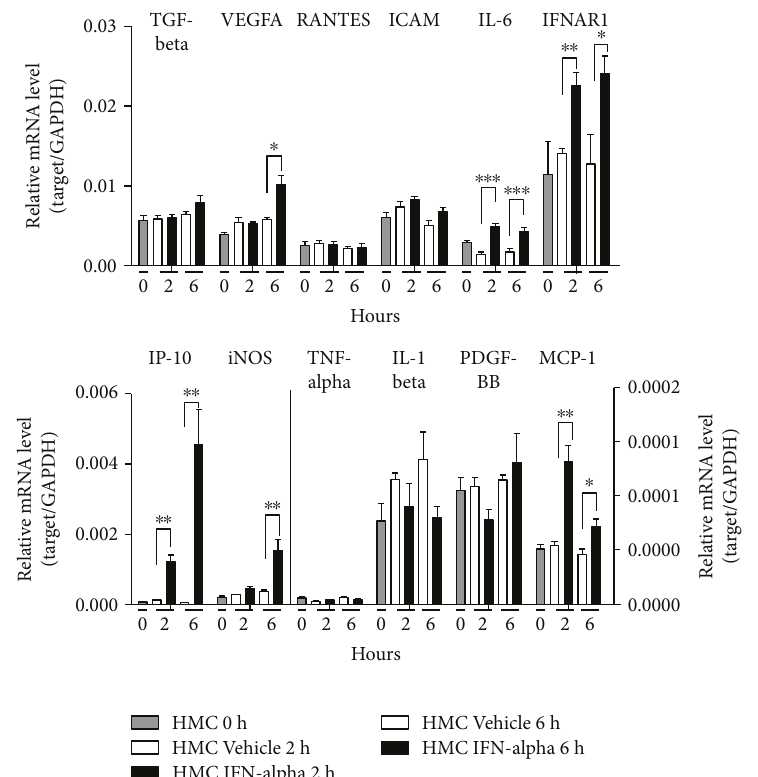
Figure 6: Regulation of gene expression by IFN- α in human mesangial cells. Human mesangial cells were subjected to serum starvation for 6h, followed by IFN- α treatment (4000IU/ml) for varied time points (0min, 2 h, and 6 h). The mRNA levels of TGF-beta, VEGFA, RANTES, ICAM, IL-6, IFNAR1, IP-10, iNOS, TNF- α , IL-1 β , PDGF-BB, and MCP-1 were measured by real-time PCR. This experiment was repeated independently at least three times, and representative data are shown. ∗ p < 0 05 , ∗∗ p < 0 01 , and ∗∗∗ p < 0 001 .